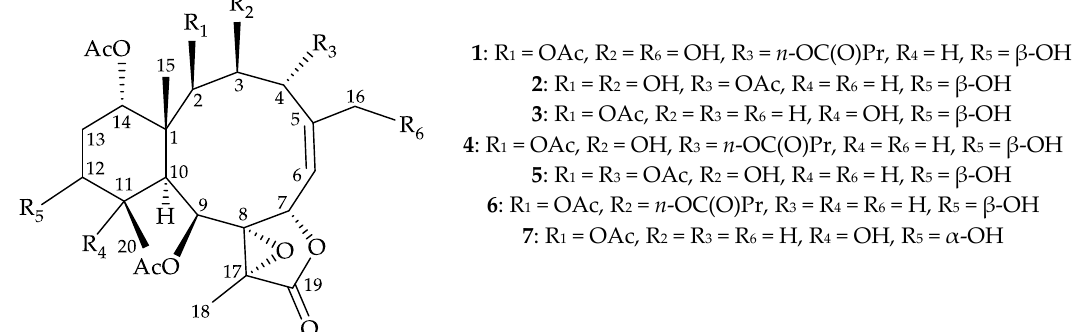
Figure 1. Structures of briarenols I–K ( 1 – 3 ), briaexcavatolide P ( 4 ), briaexcavatin P ( 5 ), excavatolide B ( 6 ), and briareolide B ( 7 ).